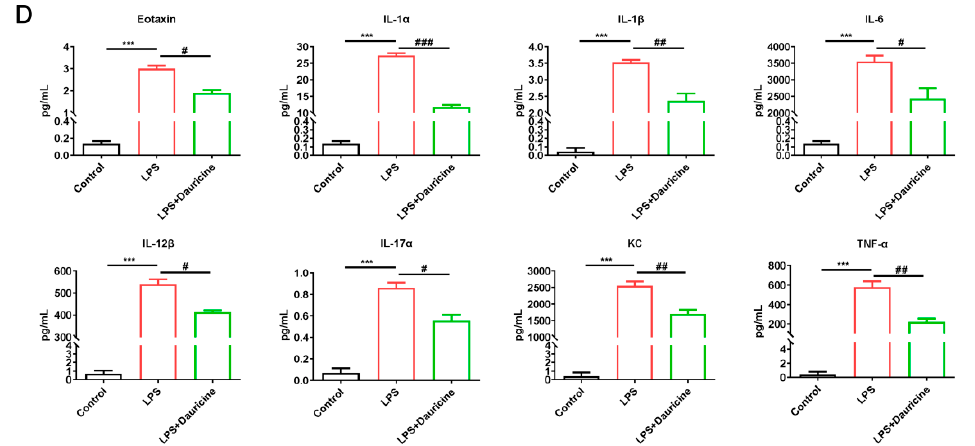
Figure 4. Dauricine decreased inflammation induced by LPS or tMCAO injury. ( A ) Diagram of ischemic penumbra, and samples from homogenate of brain infarct were analyzed with the inflamma- tion mRNA IL-1 β , IL-6 and TNF- α at tMCAO day 7, n = 3. Sham group vs. MCAO group, * p < 0.05, ** p < 0.01; MCAO group vs. MCAO + Dauricine group, # p < 0.05. ( B ) The diagram of LPS or dauricine stimulated primary microglia, and collected the samples as shown. ( C ) The microglia cell lysate was measured with inflammation mRNA IL-1 β , IL-6 and TNF- α , n = 3. Control group vs. LPS group, *** p < 0.001; LPS group vs. (LPS + Dauricine) group, # p < 0.05, ## p < 0.01, ### p < 0.001, unpaired Student’s t -test. ( D ) The inflammation cytokines measured by Luminex liquid suspension chip for the cell supernatant, and cytokines as follows: Eotaxin, IL-1 α , IL-1 β , IL-6, IL-12 β , IL-17 α , KC, TNF- α n = 3, Control group vs. LPS group, *** p < 0.001; LPS group vs. (LPS + Dauricine) group, # p < 0.05, ## p < 0.01, ### p < 0.001, unpaired Student’s t